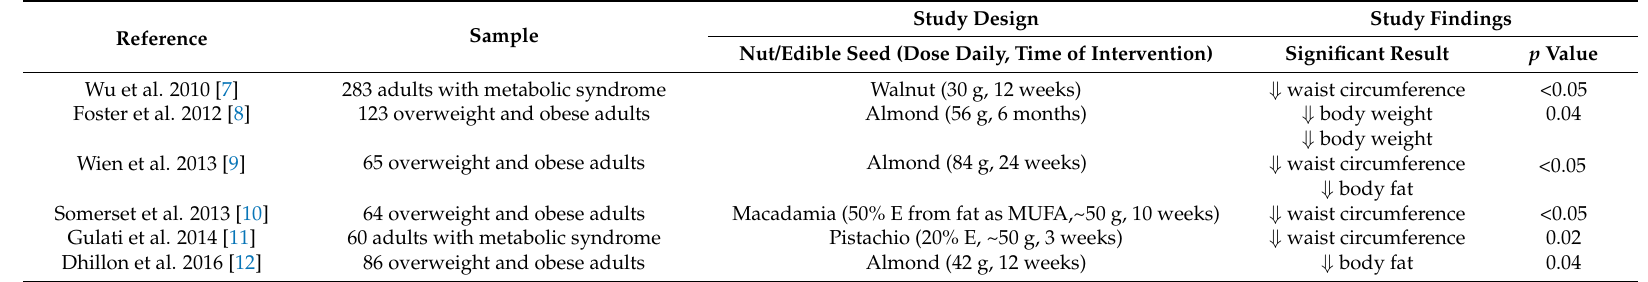
Table 1. Summary of clinical trials about the effects of nut consumption on body